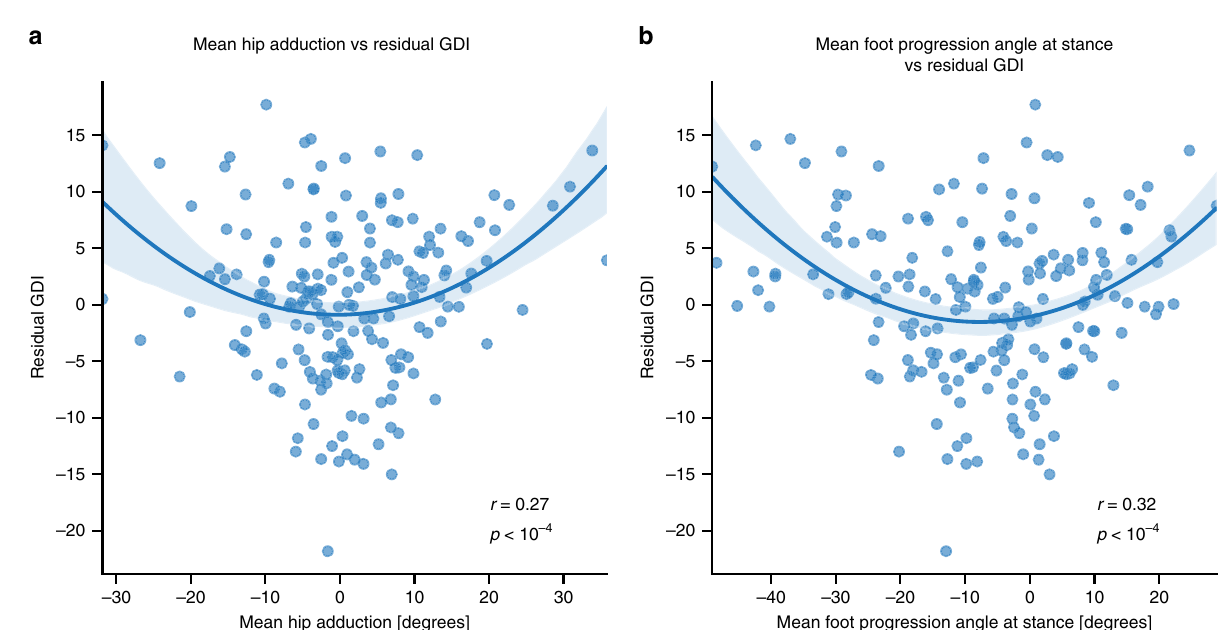
Fig. 4 Correlation between GDI prediction residuals and non-sagittal-plane kinematics. The residuals from predicting GDI from video are correlated with the mean ( a ) foot progression and ( b ) hip adduction angles derived from optical motion capture. These correlations suggest that the foot progression and hip adduction angles, which are inputs to the calculation of ground-truth GDI, are not fully captured in the sagittal-plane video. We tried linear and quadratic models and chose the better one by the Bayesian Information Criterion. In each plot, the blue curve corresponds to the best quadratic fi t to predicted vs. observed data while the light band corresponds to the 95% con fi dence interval for the regression curve derived using bootstrapping ( n = 200 bootstrapping trials). We tested if each fi t is signi fi cant by using the F -test and we reported corresponding p